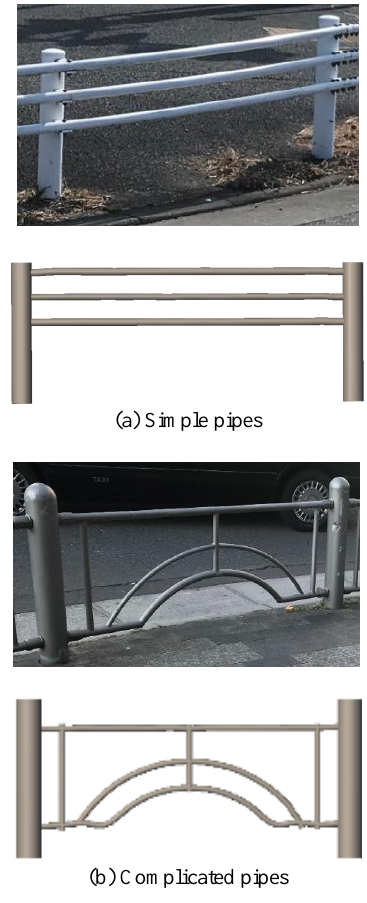
Figure 20. Unit shapes of guardrails consisting of pipes